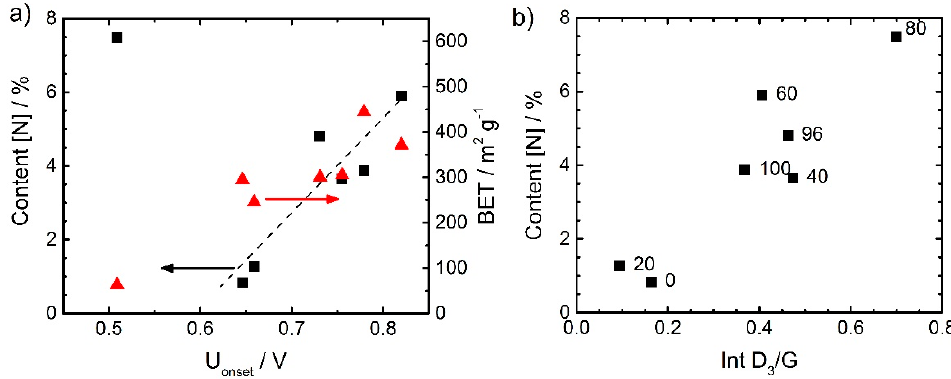
Figure 6. Correlation between the nitrogen content from elemental analysis (left axis, ■ ) as well as BET surface area (right axis, ▲ ) and the onset potential ( a ) (defined as potential at − 0.1 mA cm − 2 ) and correlation between the nitrogen content and the intensity ratio D 3 /G from Raman spectroscopy ( b ).